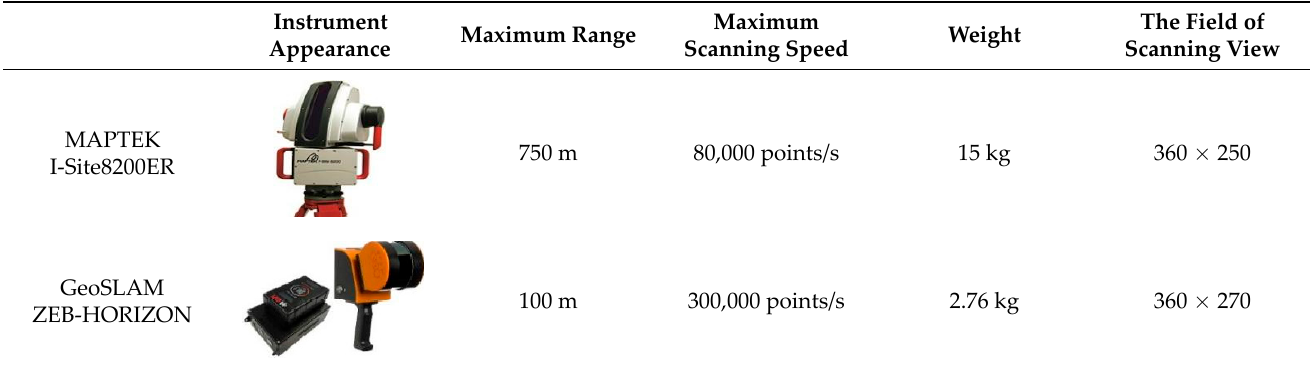
Table 1. Parameters of the 3D laser scanners.